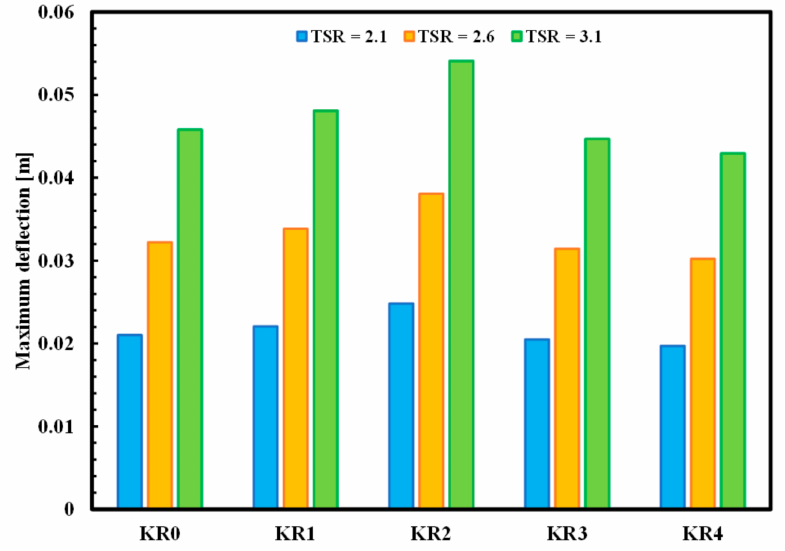
Figure 12. The maximum deflection of the blades at different TSRs for different KR-type